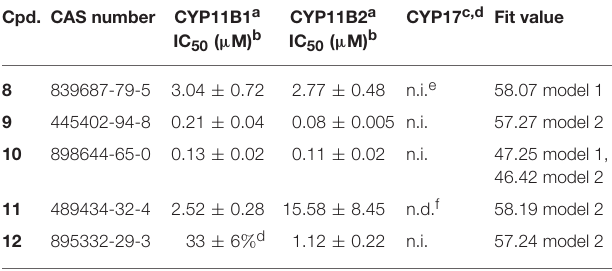
a Human CYP11B1 and CYP11B2 enzymes expressed in hamster v79MZh cells. b Mean value of at least three experiments. c Human CYP17 enzyme isolated from Escherichia coli. d Inhibition was measured at 10 µ M concentration. e n.i., not inhibited. f n.d., not determined.